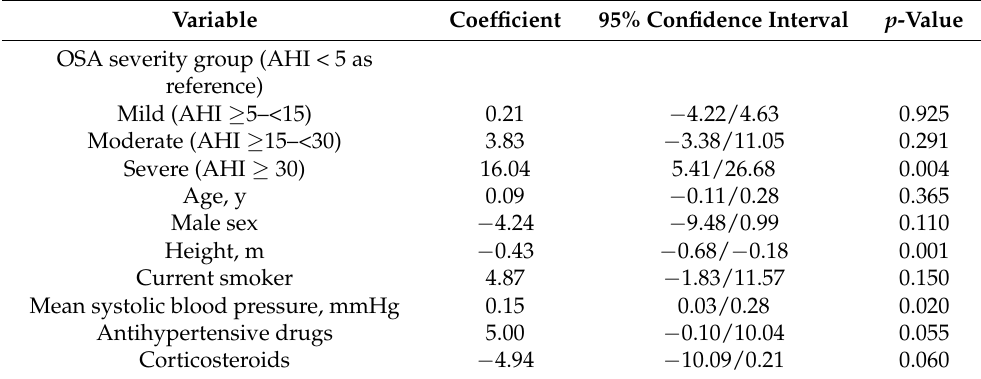
Table 4. Multivariable linear regression analysis of the aortic AIx (AP/PP) normalized for a heart rate of 75/min and OSA severity groups, adjusted for known risk